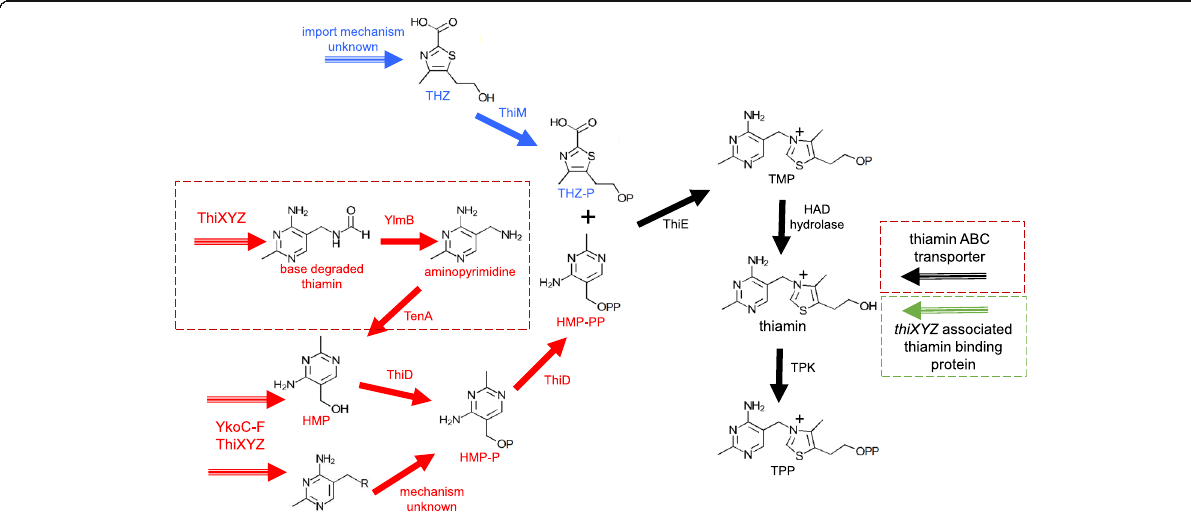
Fig. 5 Predicted thiamin salvage pathways in all three paenibacilli. Pathways involved in thiazole salvage are highlighted in blue and pathways involved in pyrimidine salvage are shown in red. The dotted red boxes are steps unique to P. thiaminolyticus NRRL B-4156 and P. dendritiformis C454. Biosynthetic pathways are shown with solid arrows and import pathways are indicated with a striped arrow. The putative importer boxed in green is unique to P. apiarius NRRL B-23460. In all cases, it is not yet understood how THZ enters the